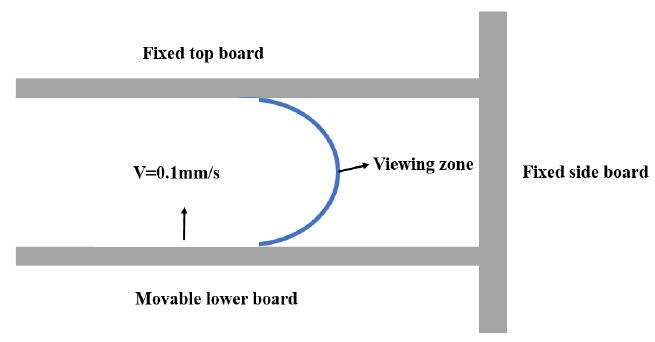
Figure 1. The schematic diagram of two-point bending test. The macro and micro images of the bent crease and resultant fracture surface of these three samples were investigated by scanning electron microscopy (Field Emission Scanning Electron Microscope, FESEM, JSM-7500F, JEOL, Japan) and transmission electron microscope (TEM, JEM-2100, JEOL, Japan). The FeSiB amorphous alloy ribbons were subjected to nano-indentation testing (Agilent G200, Keysight, Santa Rosa, CA, USA) using a Berkovich diamond indenter with an effective tip radius of 25 nm. The experimental samples were mechanically polished to ensure that the surface of the FeSiB amorphous alloy ribbons was perpendicular to the loading direction of the indenter and tested in